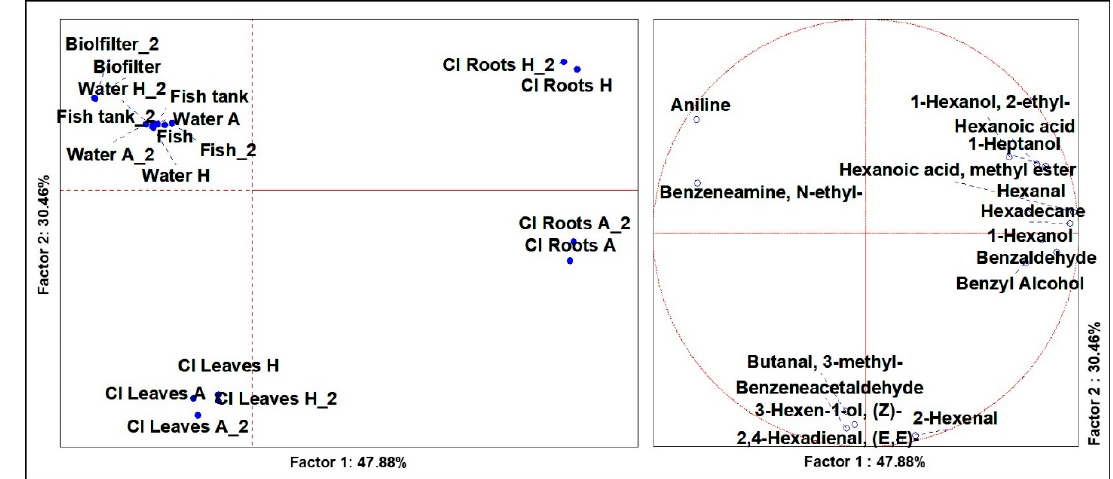
Figure 3. Principal Component Analysis (PCA) of the cases ( left ) and variables ( right ) of the significant (ANOVA p < 0.05) VOCs of Chicorium intybus .